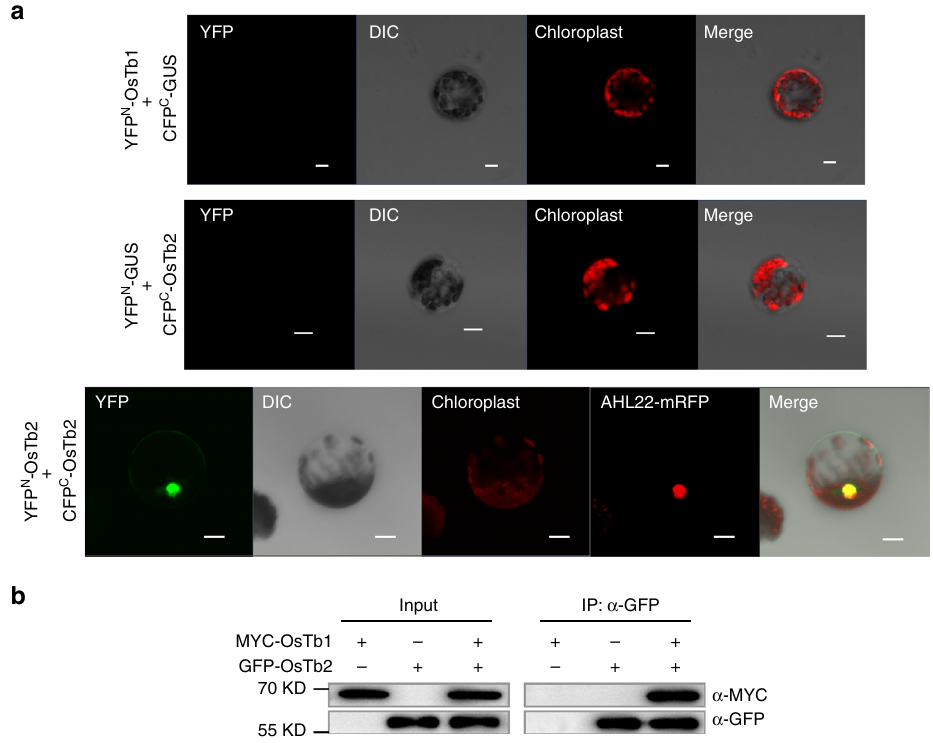
Fig. 5 OsTb2 interacts with OsTb1 in the nucleus. a YFP N -OsTb1 and CFP C -OsTb2 were expressed in a pairwise manner in rice protoplasts and exhibited a direct interaction in the nucleus, in which AHL22-mRFP was used as the nuclear marker protein; CFP C -GUS and YFP N -GUS fusion proteins were used as negative controls and were coexpressed with YFP N -OsTb1 and CFP C -OsTb2, respectively, in rice protoplasts. DIC indicates differential interference contrast transmission; the merged image is also shown; scale bar, 20 µ m. b Coimmunoprecipitation assays of OsTb1 and OsTb2. Protein extracts from rice protoplasts harbouring MYC-OsTb1 and GFP-OsTb2 were coimmunoprecipitated by anti-GFP beads and detected by anti-GFP and anti-MYC antibodies. Protoplasts transformed with single MYC-OsTb1 or GFP-OsTb2 were used as a negative control. The source data underlying Fig. 5b are provided as a Source Data fi